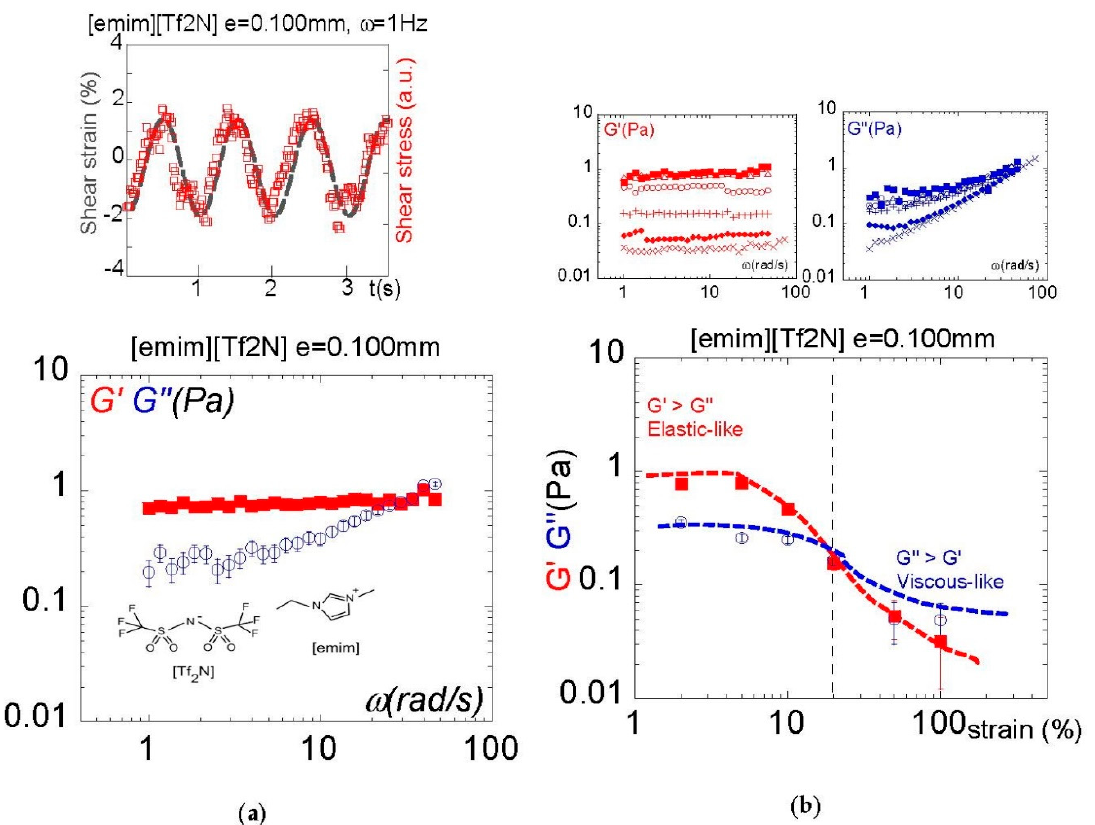
Figure 2. ( a ): Top: in-phase (input) shear strain and (output) shear stress waves at 1 Hz frequency and 2% shear strain by a 100 µm layer of [emim][Tf2N] (1-Ethyl-3-methylimidazolium bis(trifluoromethylsulfonyl)imide). Bottom: The frequency dependence of the viscoelastic moduli indicate a low-frequency elastic-like presence, with the shear modulus G ′ being higher than the viscous modulus G ″ up to 20 rad/s. Measurements carried out at 100 µm gap thickness, γ = 2% strain amplitude, room temperature and total wetting conditions (Alumina). ( b ): Top: frequency dependence of the viscoelastic moduli ( G ′ , G ″ ) displayed by the ionic liquid [emim][Tf2N] at 100 µm gap thickness and different strain amplitudes. Bottom: Shear strain-induced transition from elastic-like to viscous-like. The shear modulus G ′ higher than the viscous modulus G ″ progressively vanishes with increasing strain. Measurements carried out at 2 rad/s, at room temperature using total wetting boundary conditions (alumina). The vertical dashed line indicates the separation line between the elastic and the viscous regimes. The continuous lines are eye guides.